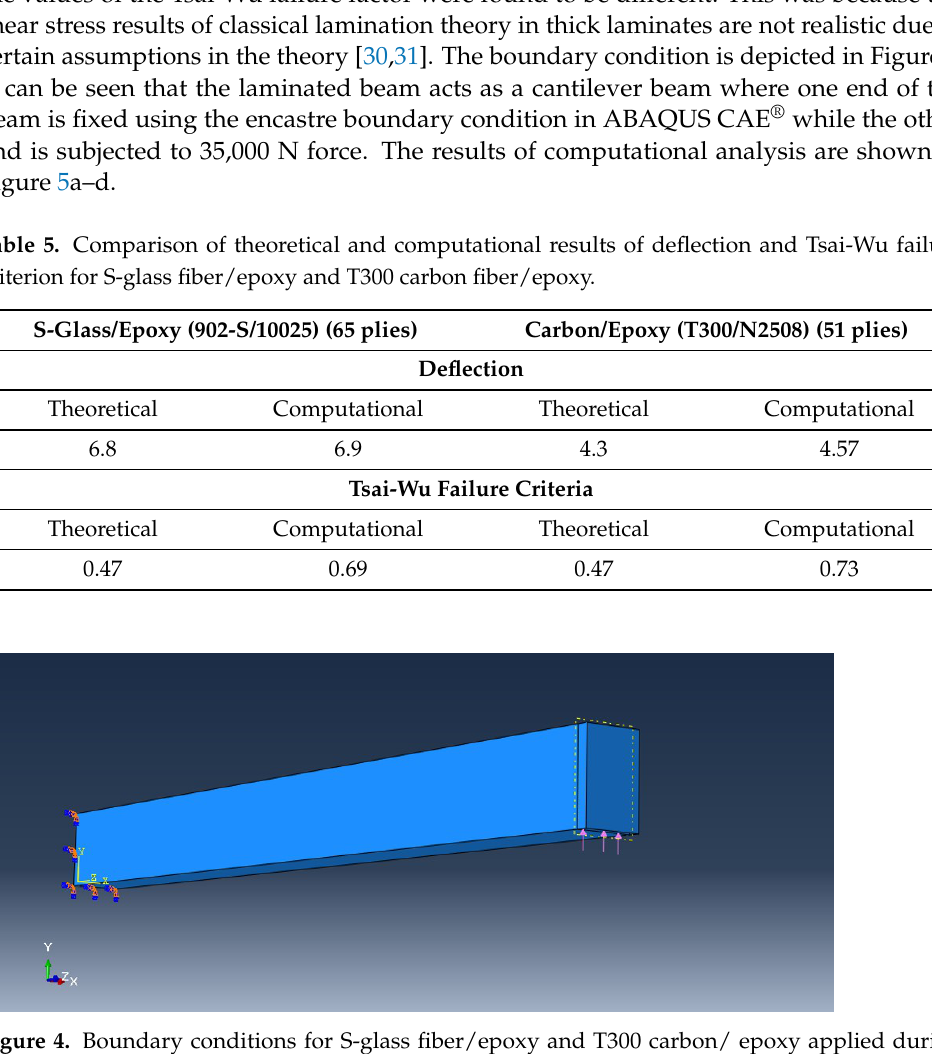
Figure 4. Boundary conditions for S-glass fiber/epoxy and T300 carbon/ epoxy applied during computational analysis using Abaqus CAE ®